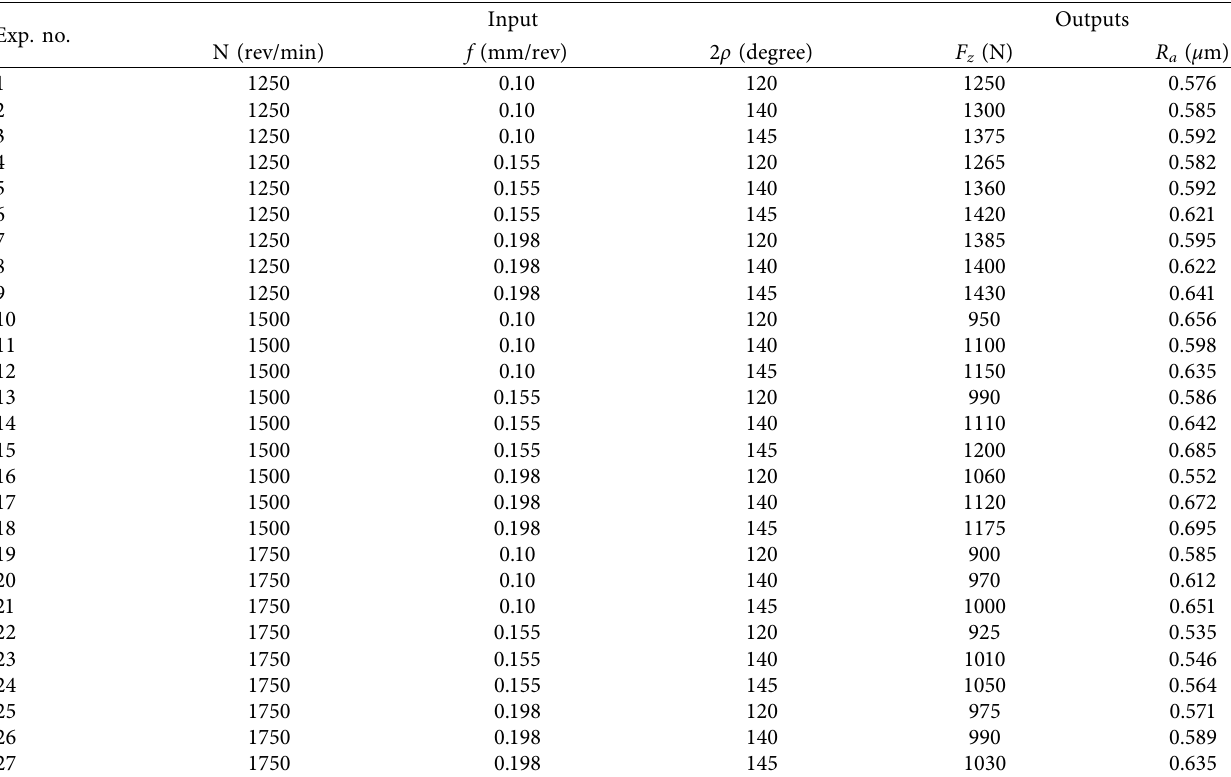
Table 2: Experiment’s